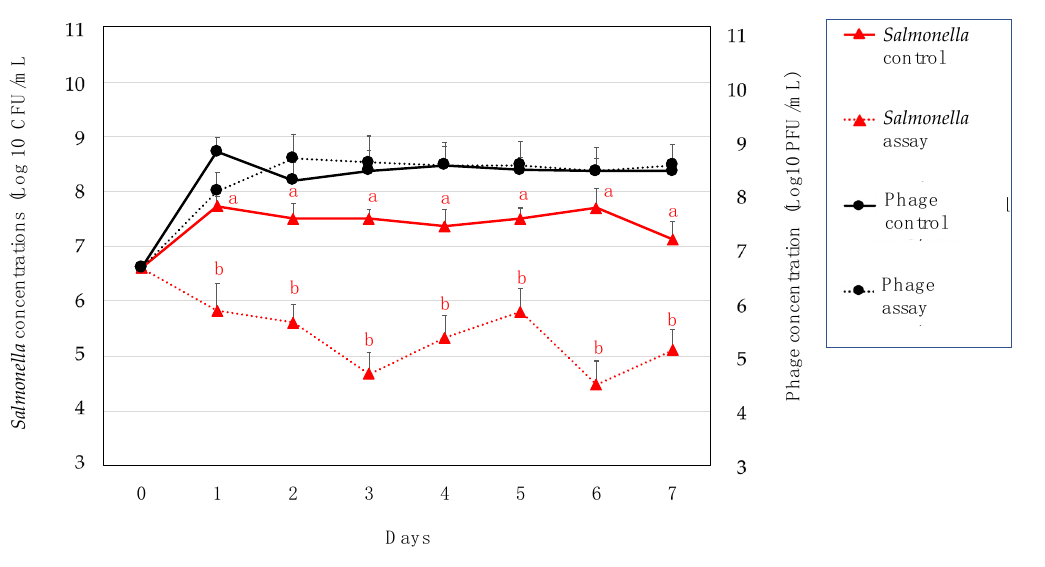
Figure 5. Chicken meat assay of S. Enteritidis and phage. This analysis represented the four experi- mental groups considered in this study in chicken meat pieces at a size of 2 cm 2 approx. Experimental groups were inoculated with: (1) phage lysate at 4 × 10 6 PFU/mL (black circle/broken lines); and (2) Salmonella ( SE nal ) at 4 × 10 6 CFU/mL (red triangles/broken lines) (MOI = 1). (3) Salmonella controls (red triangles/unbroken lines) were prepared with only Salmonella . (4) Phage control with only phage (black circle/ unbroken lines). The standard deviation was calculated between the three replicates per day, and statistically significant differences (estimated with ANOVA at p < 0.05) are indicated by different